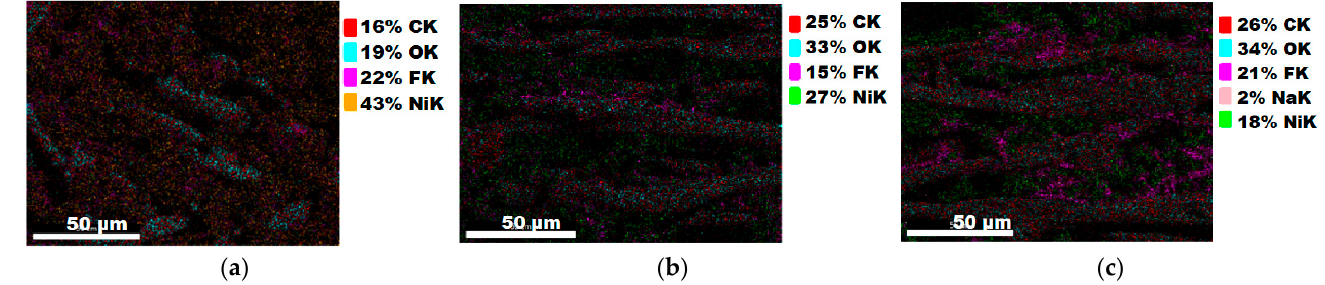
conductive paste). conductive paste).